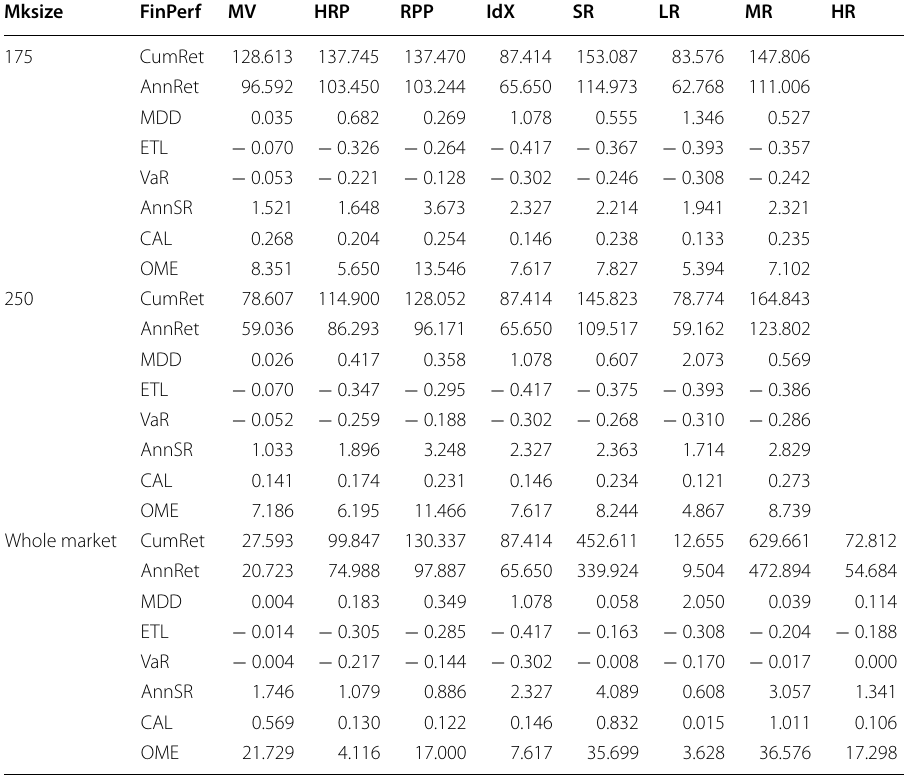
Table 4 Financial ratios of daily returns ( Rp ) for each method